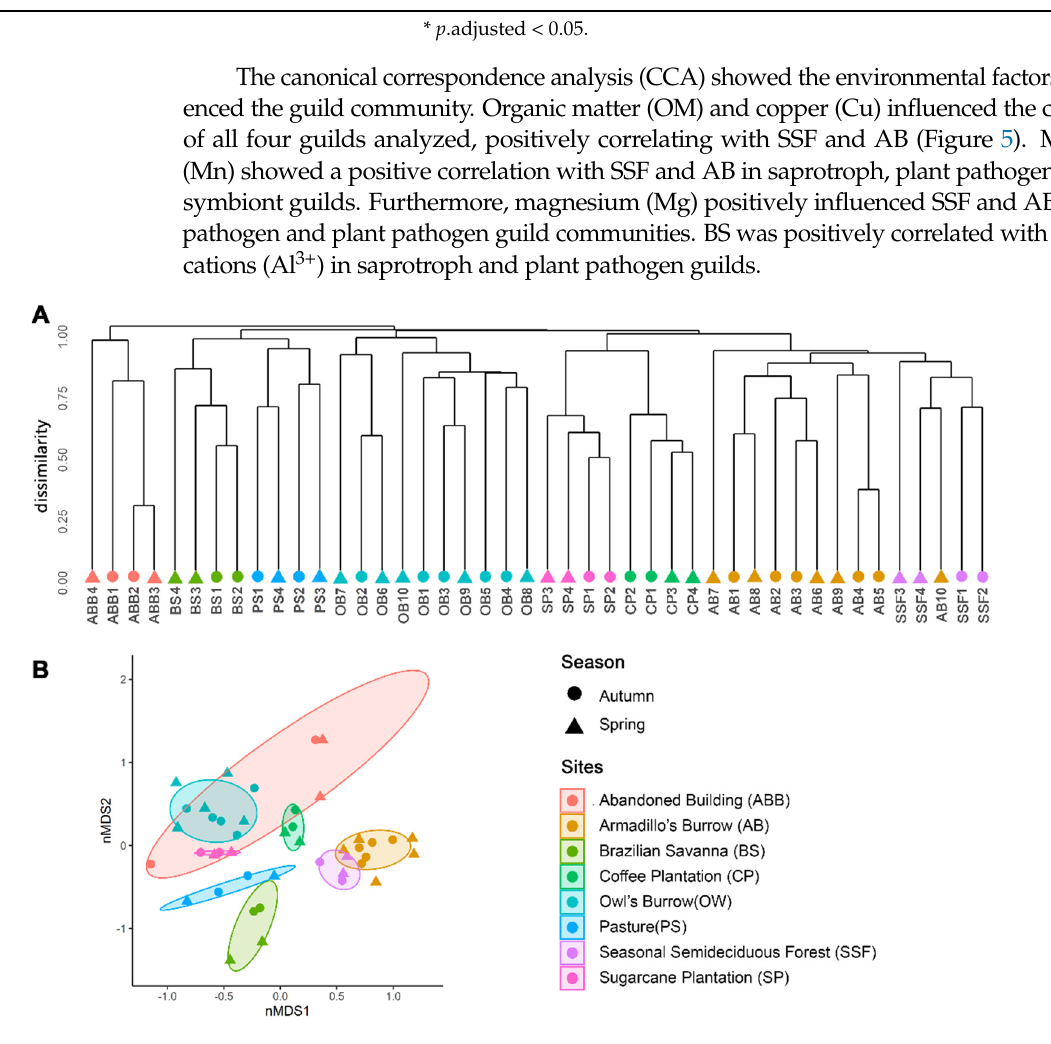
Figure 4. Cluster analysis ( A ) and non-metric multidimensional scale analysis (nMDS) ( B ) using the Bray–Curtis dissimilarity coefficient, with samples grouped by environment, showing the similarity of the fungal community structure according to habitat for both seasons (autumn represented by a circle and spring represented by a triangle). The soil chemical analysis is displayed in Table S1. Lower pH values can be observed in BS (pH 4.25) and ABB (pH 4.3) related to other environments (pH 5.25–6.35). In addition, BS showed a high value of aluminum cation (Al 3+ ) (5.25 mmolc/dm 3 ). Organic matter (OM) reaches the highest value in SSF samples and the lowest in OB and BS samples. The variation of copper (Cu) values was within 0.525–5.85 mg/dm 3 , showing lower values in BS, OB and SP. Manganese (Mn) and magnesium (Mg) showed high concentrations in ABB, AB and SST. The canonical correspondence analysis (CCA) showed the environmental factors that influenced the guild community. Organic matter (OM) and copper (Cu) influenced the community of all four guilds analyzed, positively correlating with SSF and AB (Figure 5). Manganese (Mn) showed a positive correlation with SSF and AB in saprotroph, plant pathogen and plant symbiont guilds. Furthermore, magnesium (Mg) positively influenced SSF and AB in animal pathogen and plant pathogen guild communities. BS was positively correlated with aluminum cations (Al 3+ ) in saprotroph and plant pathogen guilds.